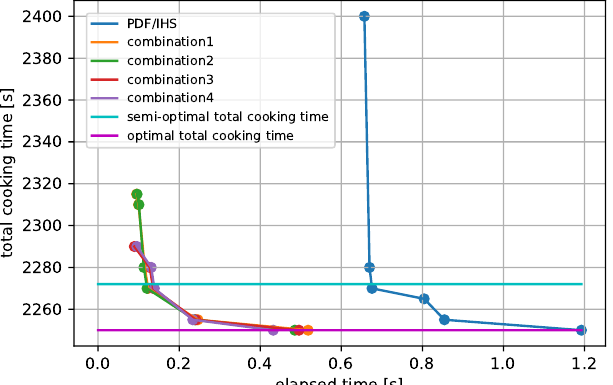
Figure 7. Tentative solution updates (menu 1).